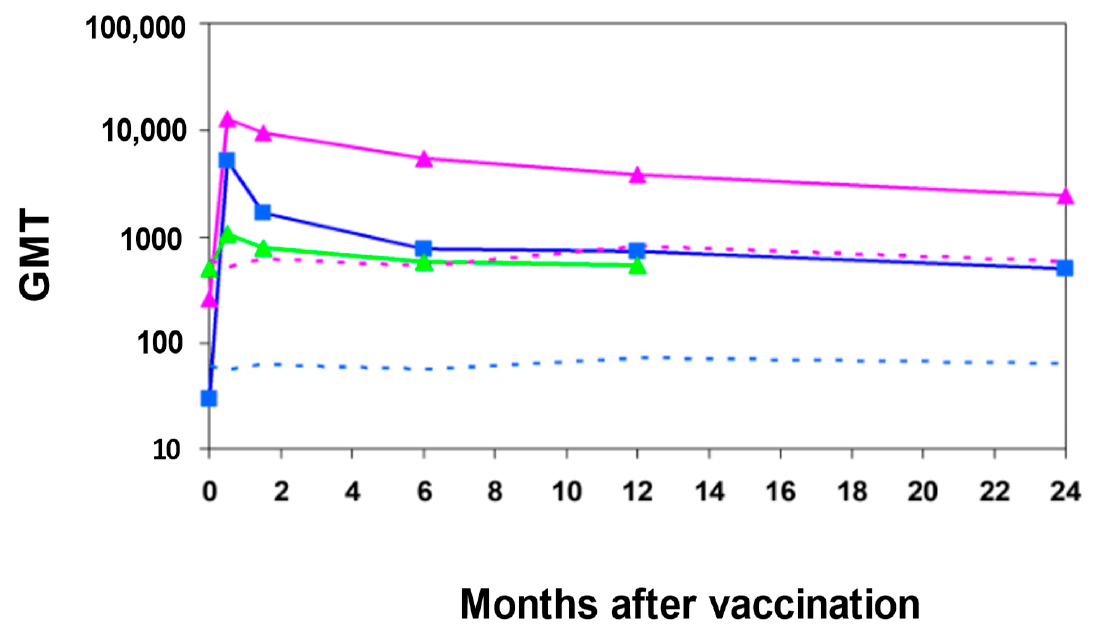
Figure 2. Geometric mean titer of S. sonnei LPS antibodies after immunization with one dose of the S. sonnei -rEPA conjugate. Pink, blue and green lines stand for IgG, IgA and IgM anti- S. sonnei LPS antibodies, respectively. Dotted lines are for hepatitis B vaccinees who served as controls; blue for IgA and pink for IgG anti- S. sonnei LPS; GMT = Geometric mean titer. Cohen D. et al. Infect. Immun. 1996 [46].